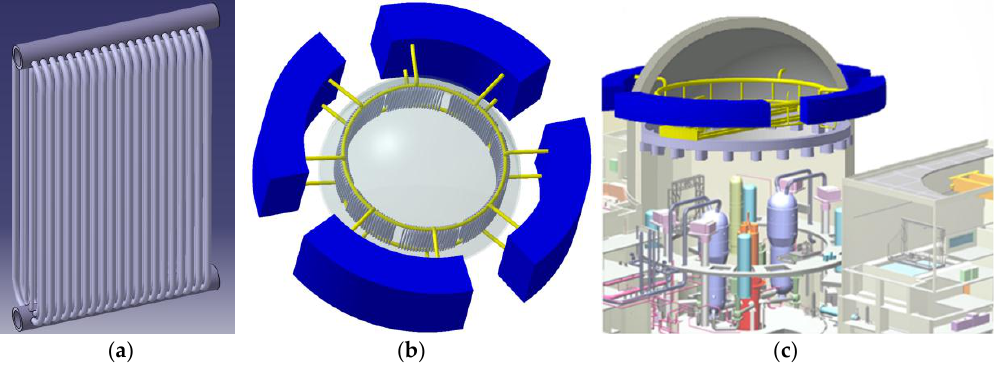
Figure 1. General concept of the passive containment cooling system (PCCS) with internal condensers. ( a ) Bundles of vertical condenser tubes; ( b ) Four trains of tube bundles connected to the passive containment cooling tank; ( c ) PCCS installed in the containment building.